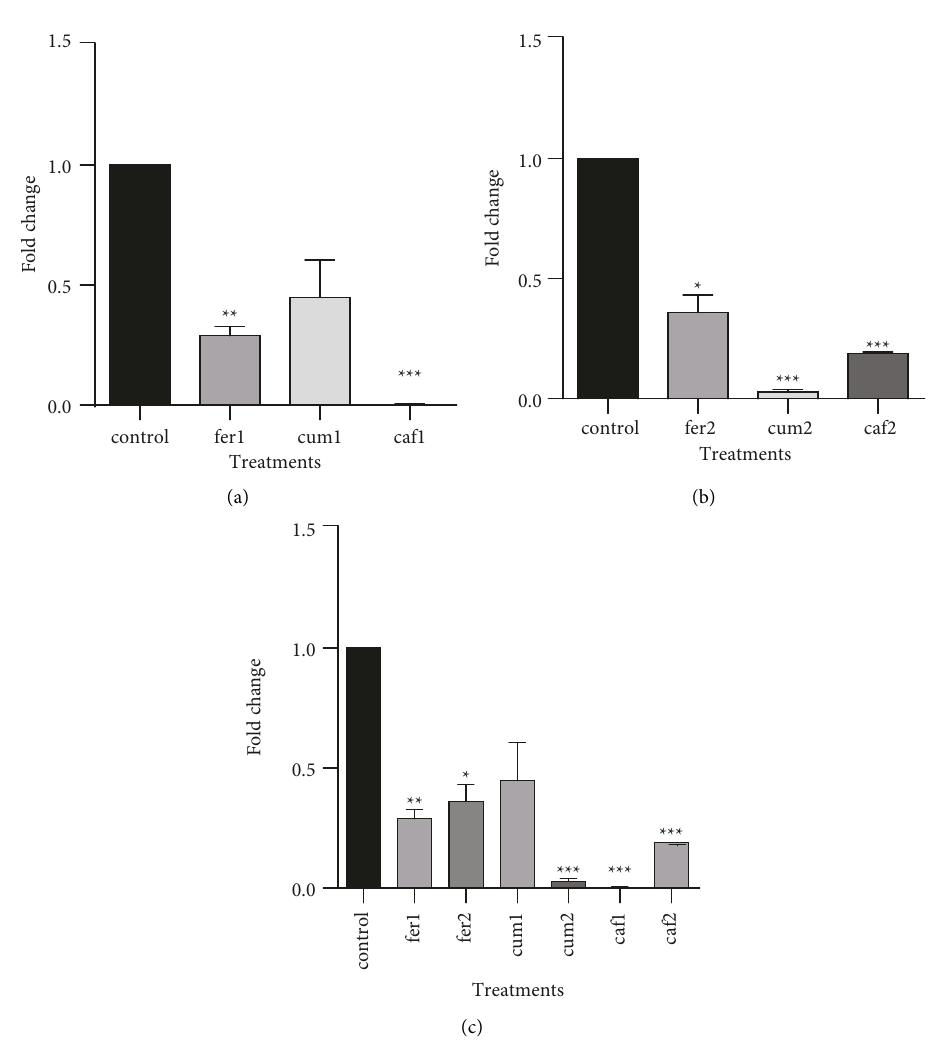
Figure 2: Transcription level of hTERT using real-time PCR experiments. The mean ± SD values of three repeats of each sample are presented. (a) Cells treated with the concentration equal to 600 µ g/ml. (b) Cells treated with the concentration equal to 1200 µ g/ml. Fer: ferulic acid, Cum:coumaric acid, and Caf : caffeic acid. All values are expressed as mean ± SD.; n � 3 per group; p < 0 . 05, ∗ p < 0 . 001 ∗∗ p < 0 . 001 ∗∗ , p < 0.001 ∗∗∗ vs control group.